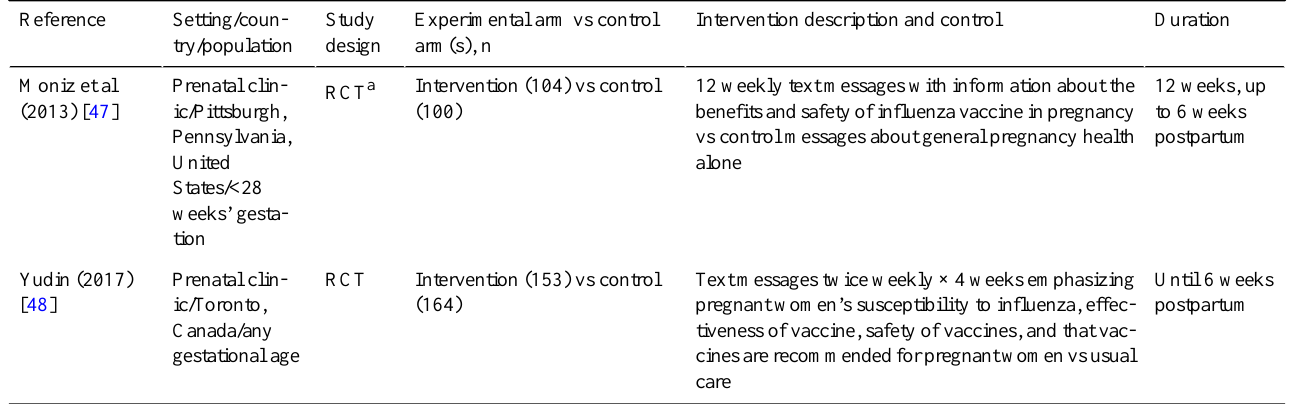
Table 5. Design of trials with a focus on influenza vaccination.